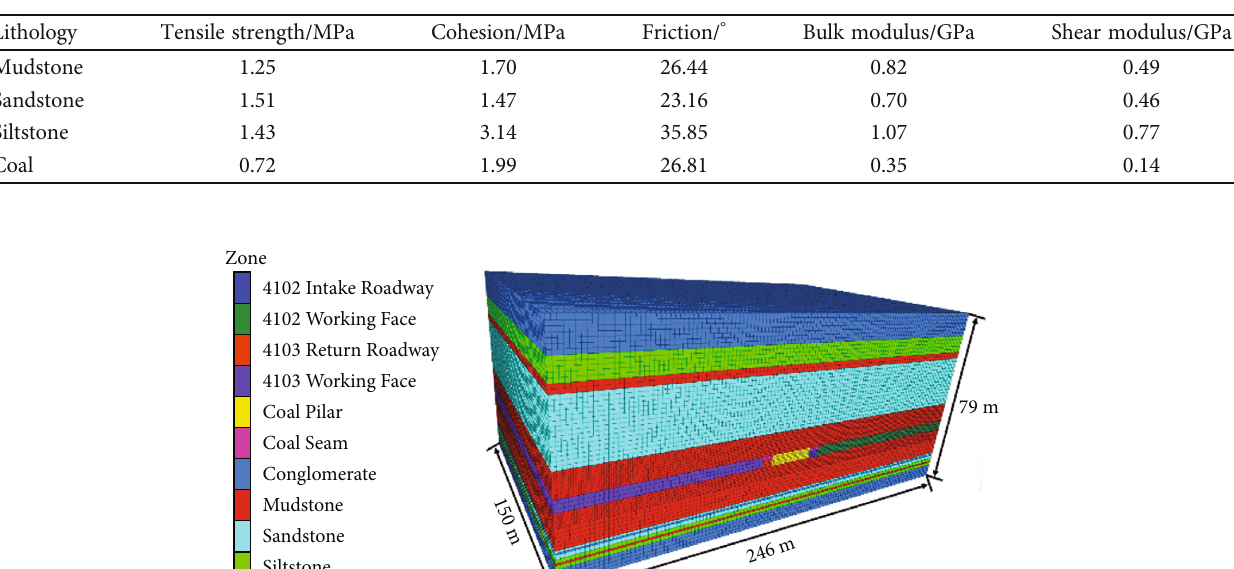
Table 2: Model parameters.